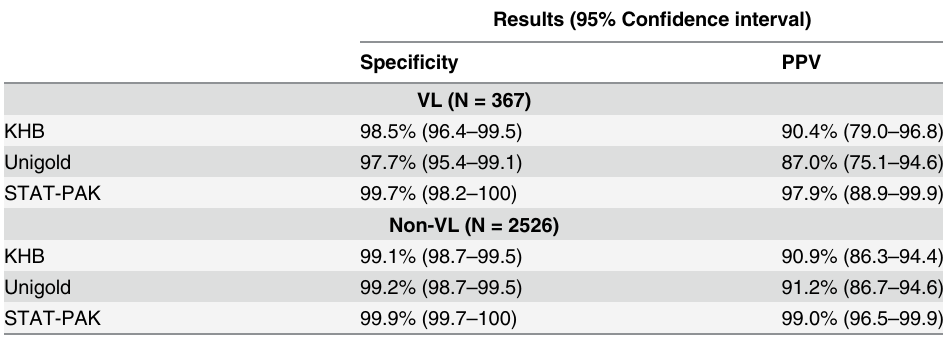
Table 3. Specificity and positive predictive values of individual rapid diagnosis tests (RDTs) by vis- ceral leishmaniasis (VL)